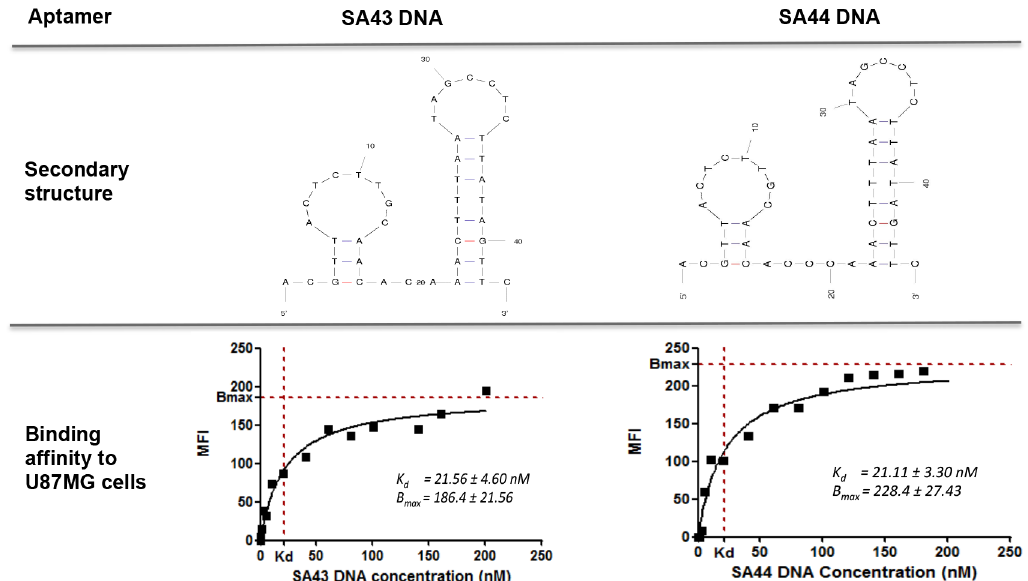
Fig 1. Predicted secondary structures and binding affinity to U87MG cells of aptamers SA43 and SA44 DNA. A represents similar secondary structures of SA43 and SA44 aptamers predicted by the M-fold software (Zuker, 2003). Dashes between nucleotides indicate Watson-Crick base pairing. B represents binding affinity of aptamers SA43 and SA44 to live U87MG cells analysed by flow cytometry. The mean fluorescence intensity (MFI) of the cells was plotted against varying concentrations of the Cy3 labelled aptamers (0.5 – 200 nM) and analysed using non-linear regression analysis.